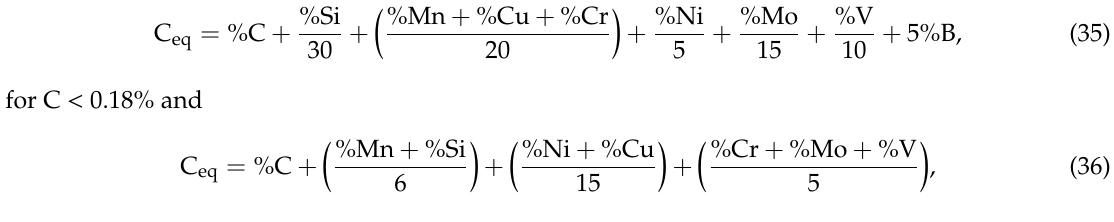
of Table A1 comprise the following: the main chemical composition of the alloy expressed in weight percentage (wt. %); a brief indicator of the type of alloy (steel); the testing methodology (C: